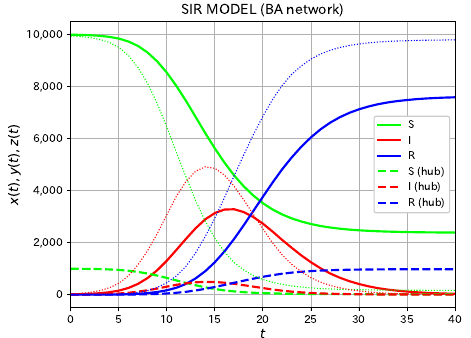
Figure 10. The contribution of the hub in the time variation of the microscopic SIR model on the BA network. The rate constants are the same as in Figure 9. Time variation of the total nodes are represented by a solid curve and that of the nodes within the hub (10%) by dashed curve. For the convenience of comparison, the ten times values of the hub are shown by a dotted